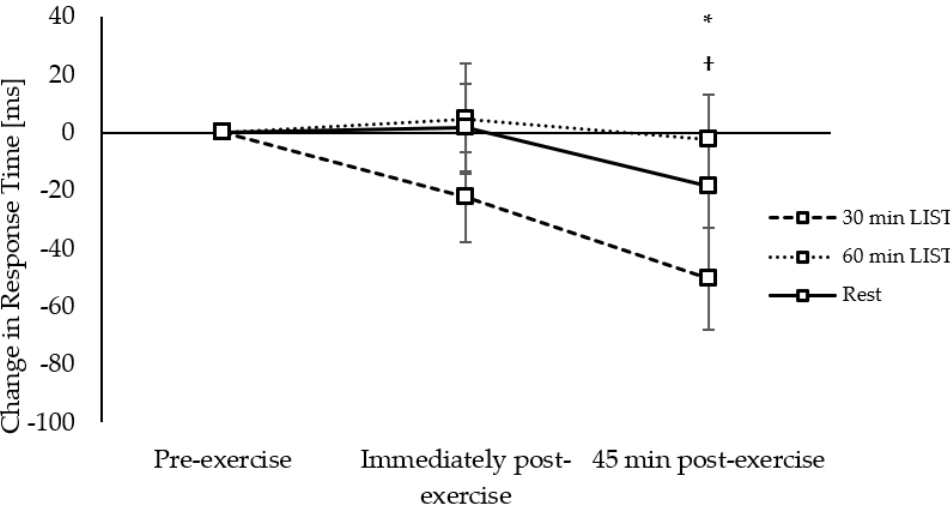
Figure 5. Change in response times across the morning on the 30 min LIST, 60 min LIST, and resting control trials on the three-item level of the Sternberg paradigm. Faster response times following 30 min LIST vs. 60 min LIST * and rest †; all p < 0.05.